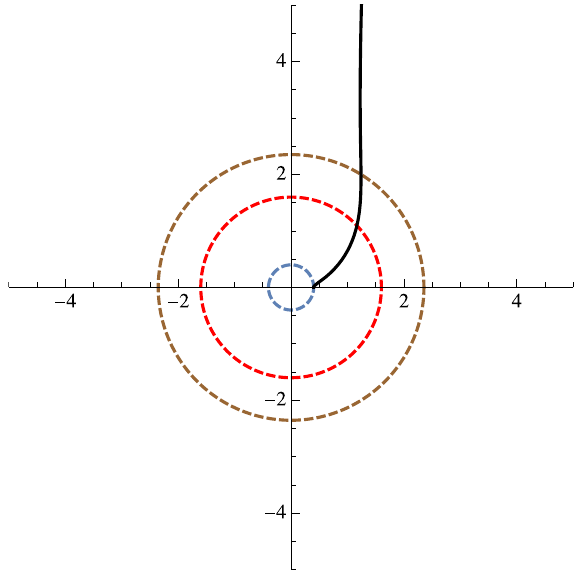
Fig. 6 The radial capture. The outer circle corresponds to r U